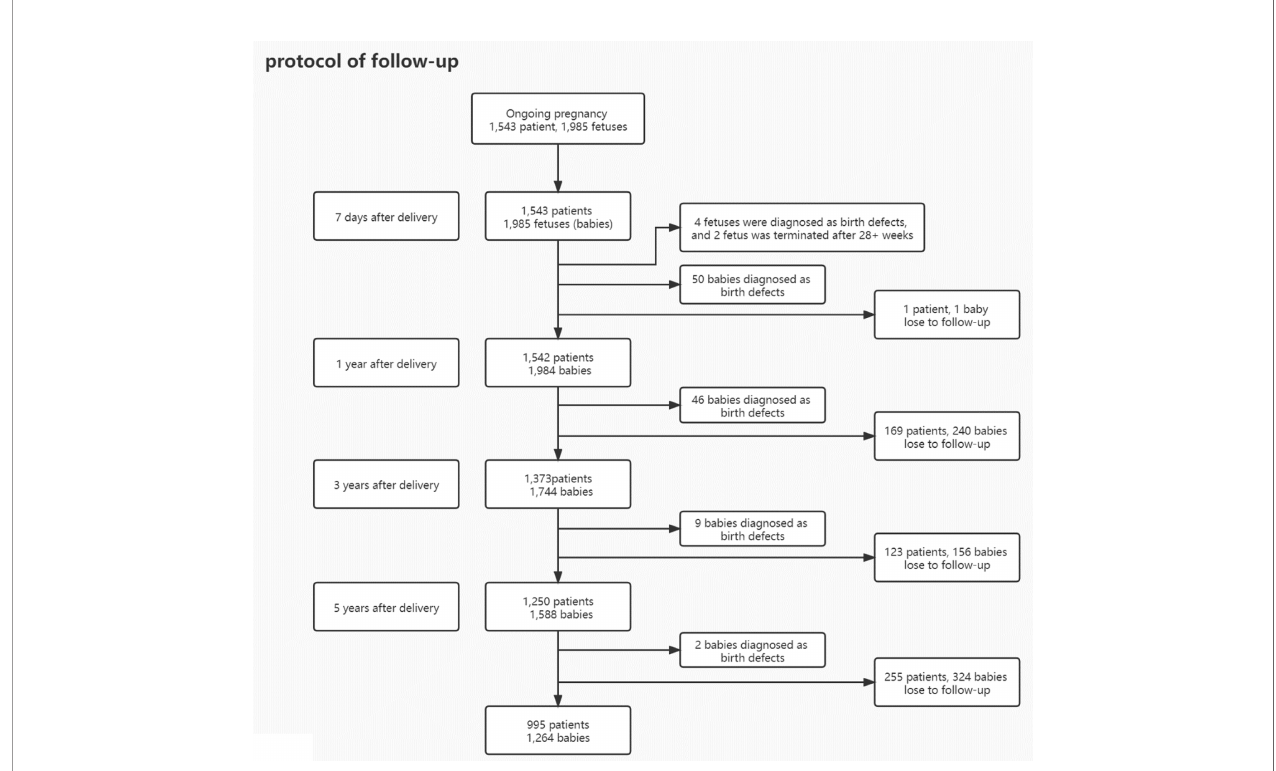
FIGURE 1 | Protocol of